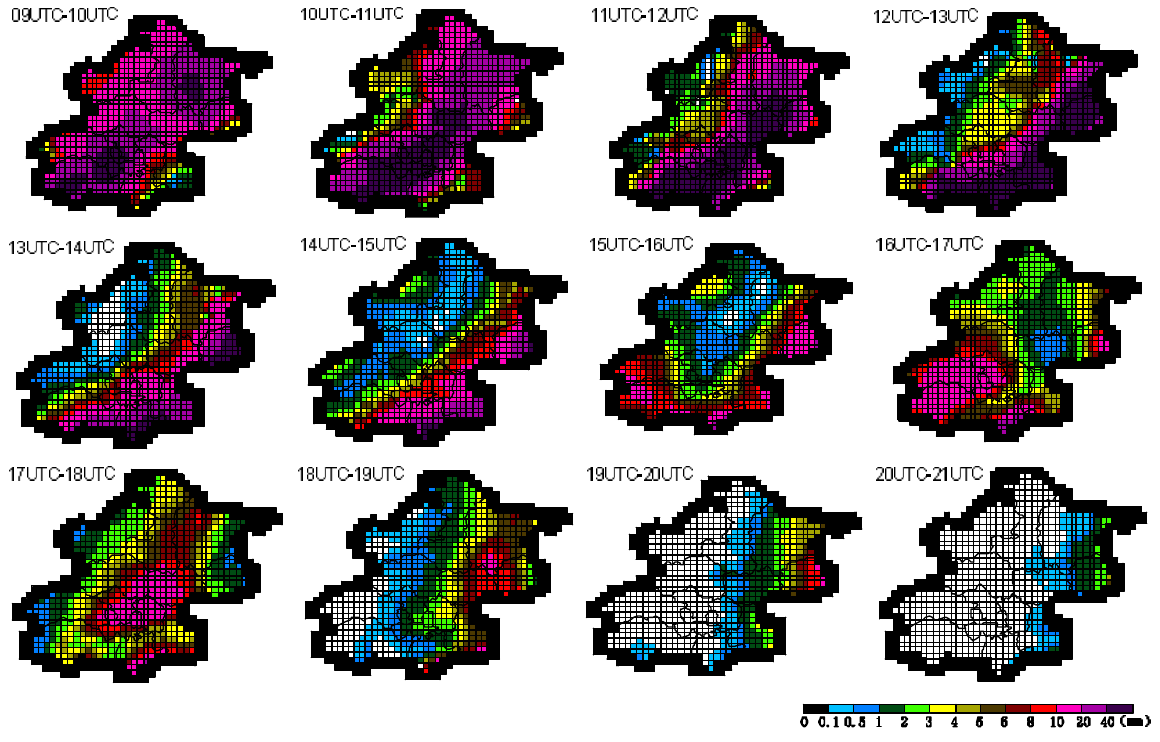
Fig. 5. Rainfall from 09:00UTC to 21:00UTC on 21 st July 2012 in Beijing